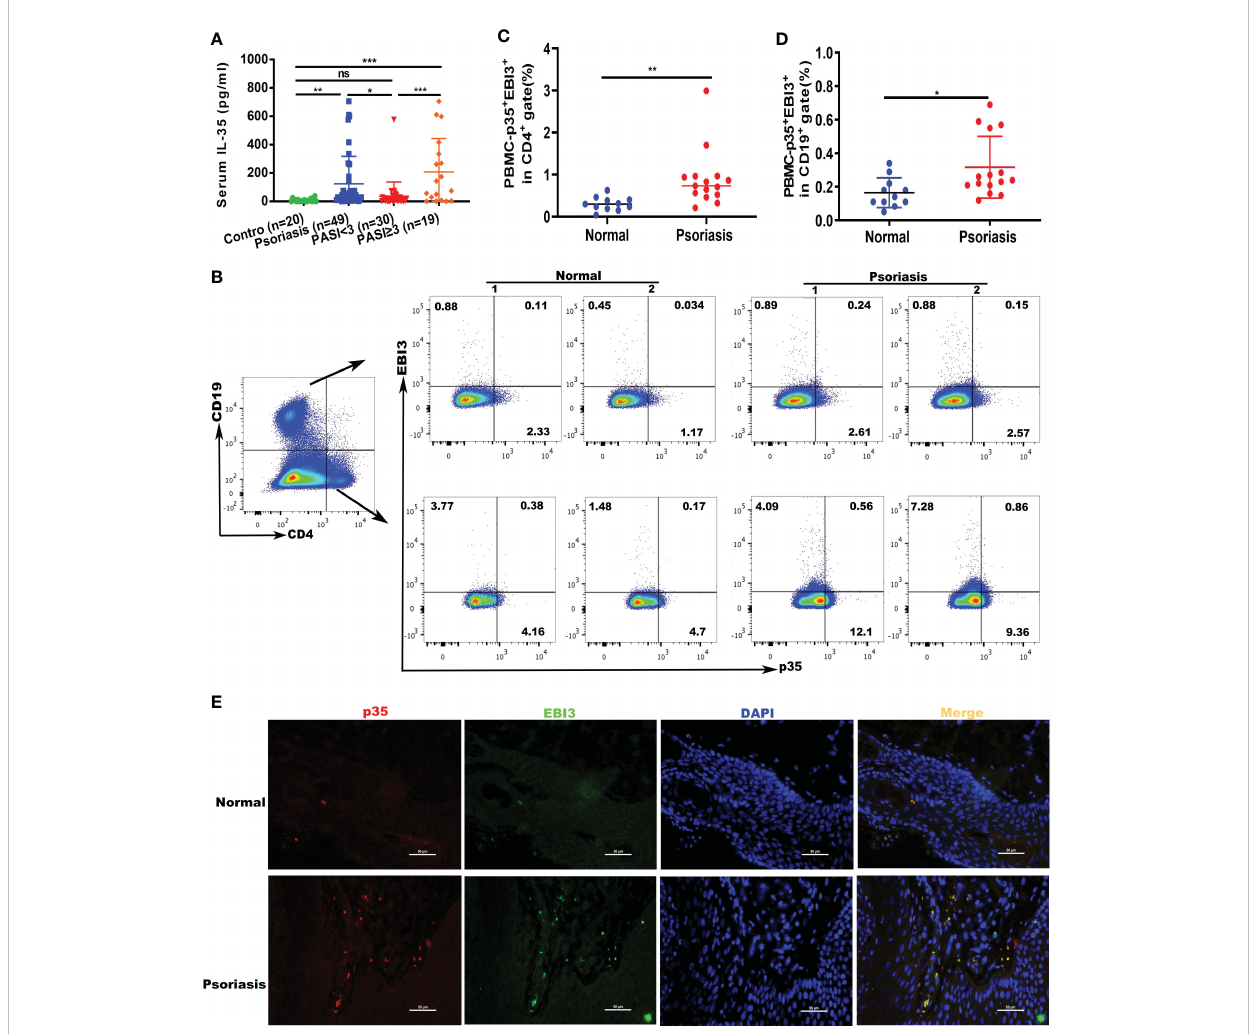
FIGURE 1 Expression of IL-35 increased in psoriatic serum and peripheral blood specimens. (A) Levels of expression of IL-35 in the serum of patients with psoriasis (n=49). Psoriasis Area and Severity Index (PASI) <3 (n=19), PASI ≥ 3 (n=19), or control (n=20) were measured using ELISA. Values obtained from individual controls and patients are plotted as dots. (B) The number of CD4 + EBI3 + p35 + and CD19 + EBI3 + p35 + cells in the peripheral blood of patients with psoriasis was detected using fl ow cytometry. (C, D) Flow cytometry proportional analysis results in (B) . (E) Immuno fl uorescence staining of IL-35 (p35 + EBI3 + ) in patients (n=7) and control (n=5) skin lesions. Red represents anti-p35 Ab, green represents anti-EBI3 Ab, yellow represents p35 and EBI3 merged, and blue represents 4 ′ ,6-diamidino-2-phenylindole (DAPI). Original magni fi cation 400×. *P<0.05, **P<0.01, ***P<0.001; ns, not signi fi